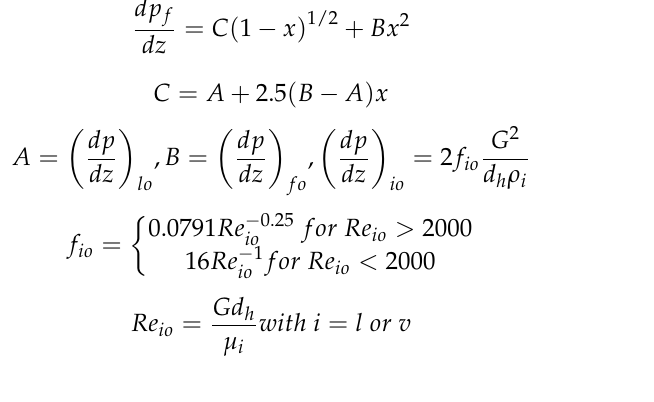
Figure 9. ( a ) Effect of saturated temperature on pressure drop and ( b ) pressure drop comparison between R410A and R448A.